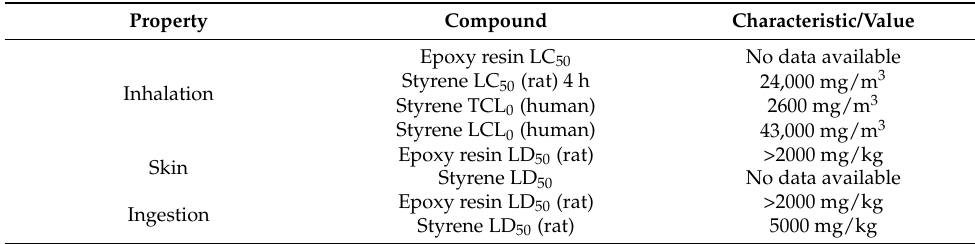
Table 3. Toxic properties of Epidian ® 53 epoxy resin [37].